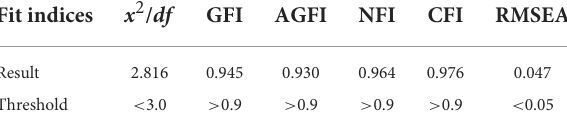
TABLE 8 Result of SEM